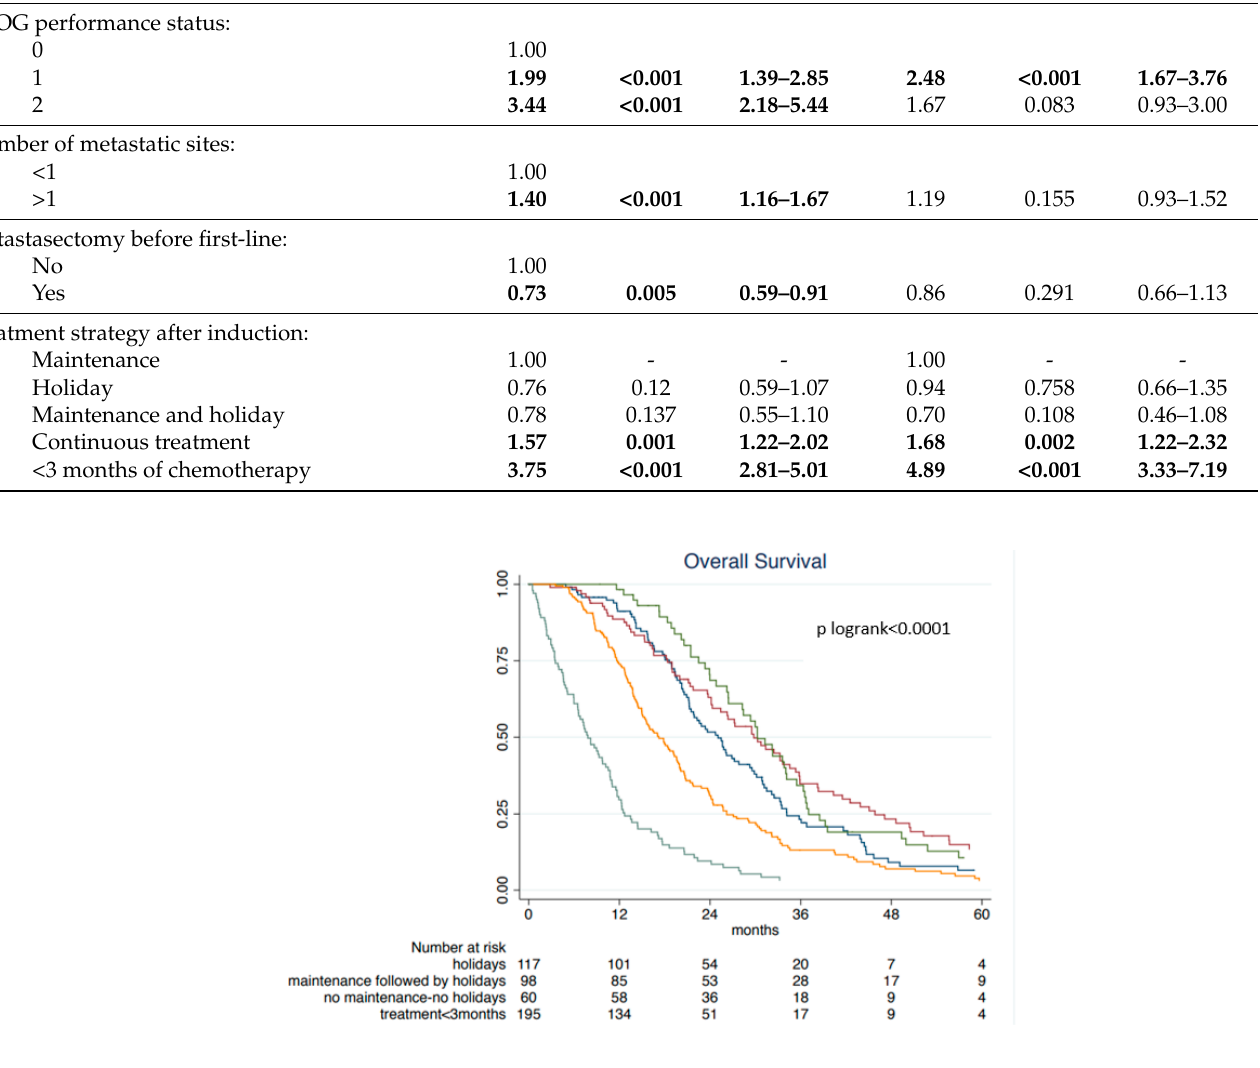
Table 2. Cont. Univariate Analysis Multivariate Analysis